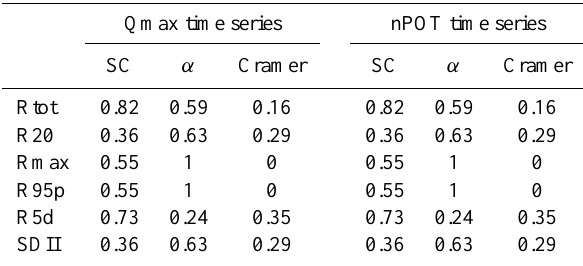
Table 6. SC and Cramer criterion values for precipitation index trends compared to Qmax trends and nPOT trends in the set of 11 short-term